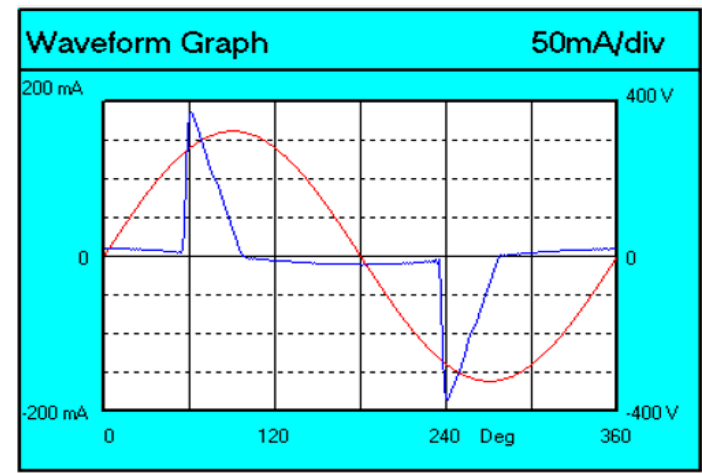
Figure 9. Waveform of voltage and current for a V-TAC lamp. Harmonics from 9 to 19 were exceeded more than three times. An analogous situation occurs during the THD test. However, the waveform test has a positive result. Observing